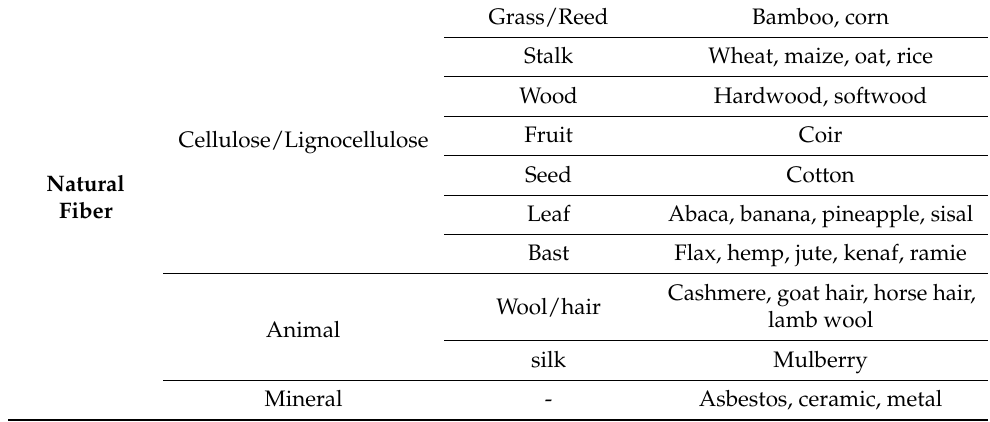
Table 1. Types of natural fibers [31–34].